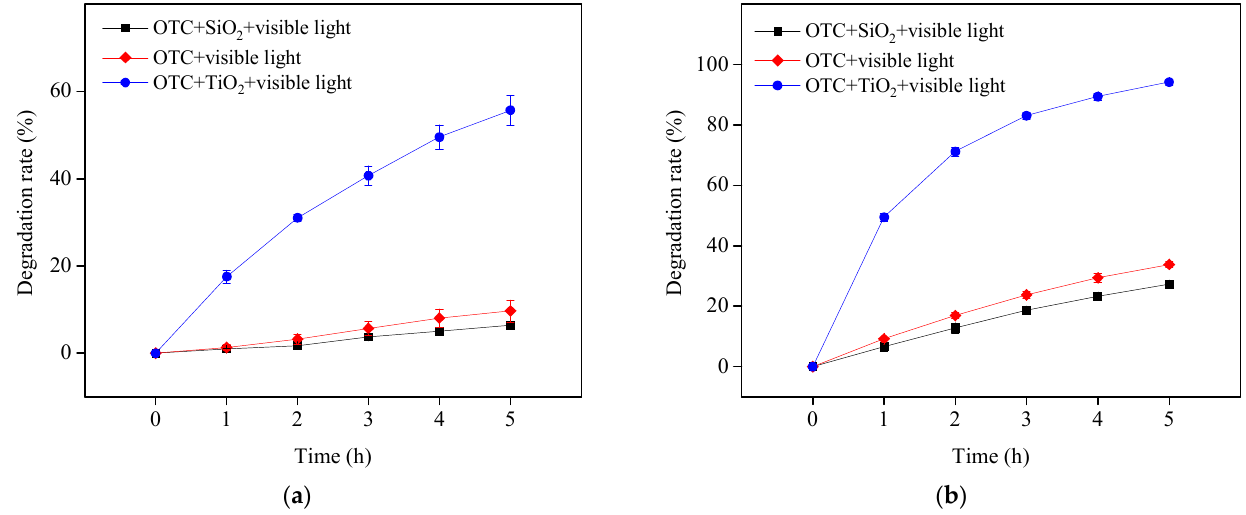
Figure 2. OTC degradation in the presence of SiO 2 under visible light irradiation at pH 5.7 ( a ) and 8.6 ( b ). Experimental conditions: [OTC] 0 = 10 mg L − 1 , [SiO 2 ] 0 = 0.5 g L − 1 , 50 mM phosphate buffer.